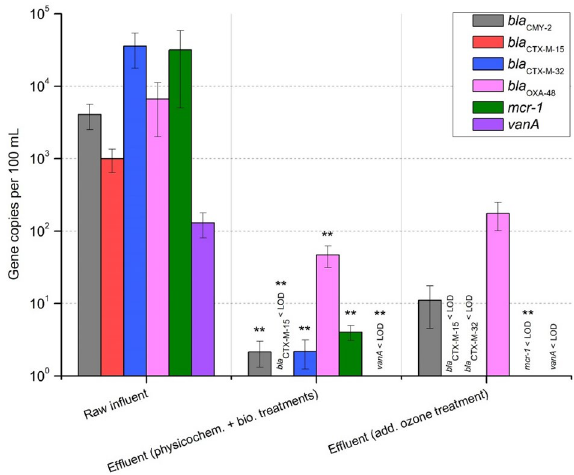
Figure 3. Abundance of “intermediate and rare abundant” antibiotic resistance genes in influent and effluent after physicochemical and biological treatments and subsequent ozone treatment. Displayed are mean values with standard deviation. Significance is given by one-tailed nonparametric Mann–Whitney U test calculation and is shown by asterisks (** p ≤ 0.001). Compared are gene copies per 100 mL in (i) raw influent with effluent after physicochemical and biological treatments and (ii) in effluent after physicochemical and biological treatments with effluent after subsequent ozone treatment. LOD – limit of